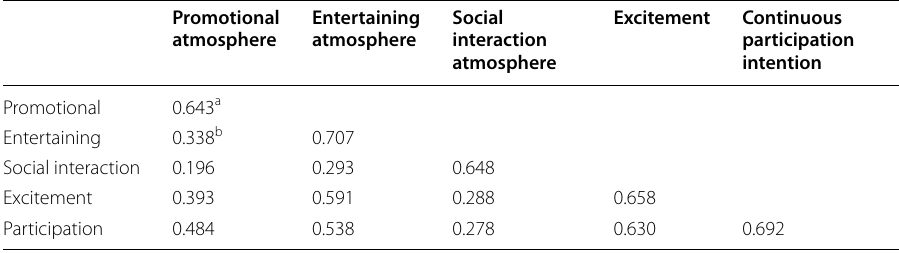
a Average variance extracted (AVE) values for the constructs are displayed on the diagonal b Numbers below the diagonal are the squared correlation estimates of the two variables